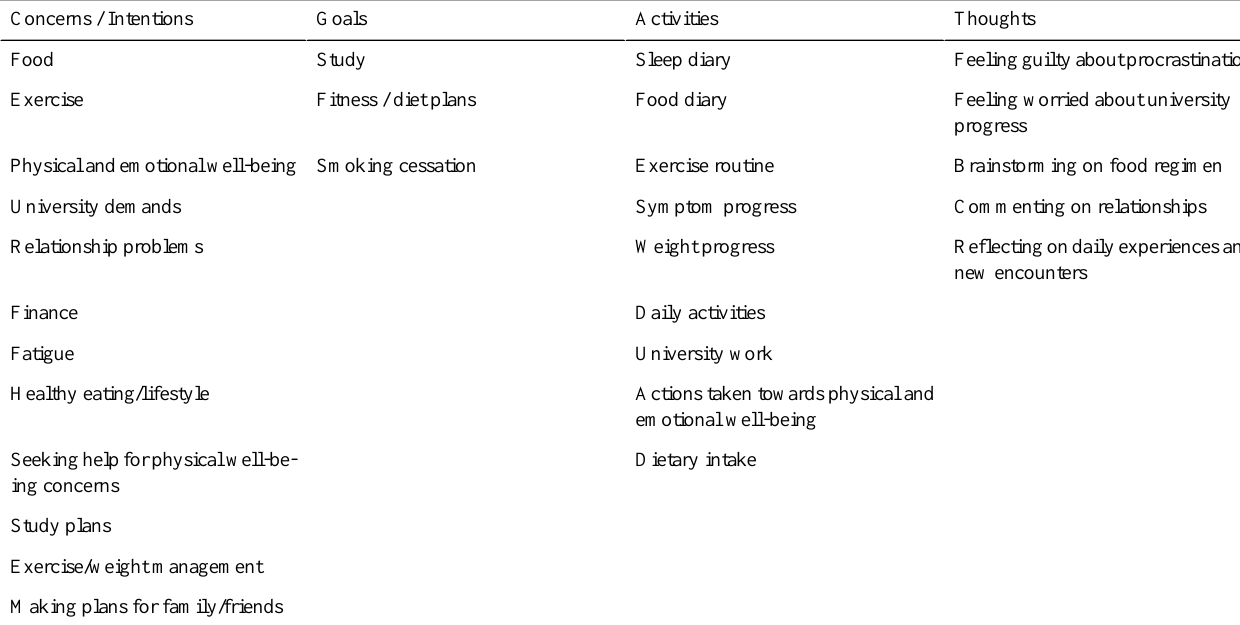
Table 8. Issues recorded by participants in their diary entries (n=140